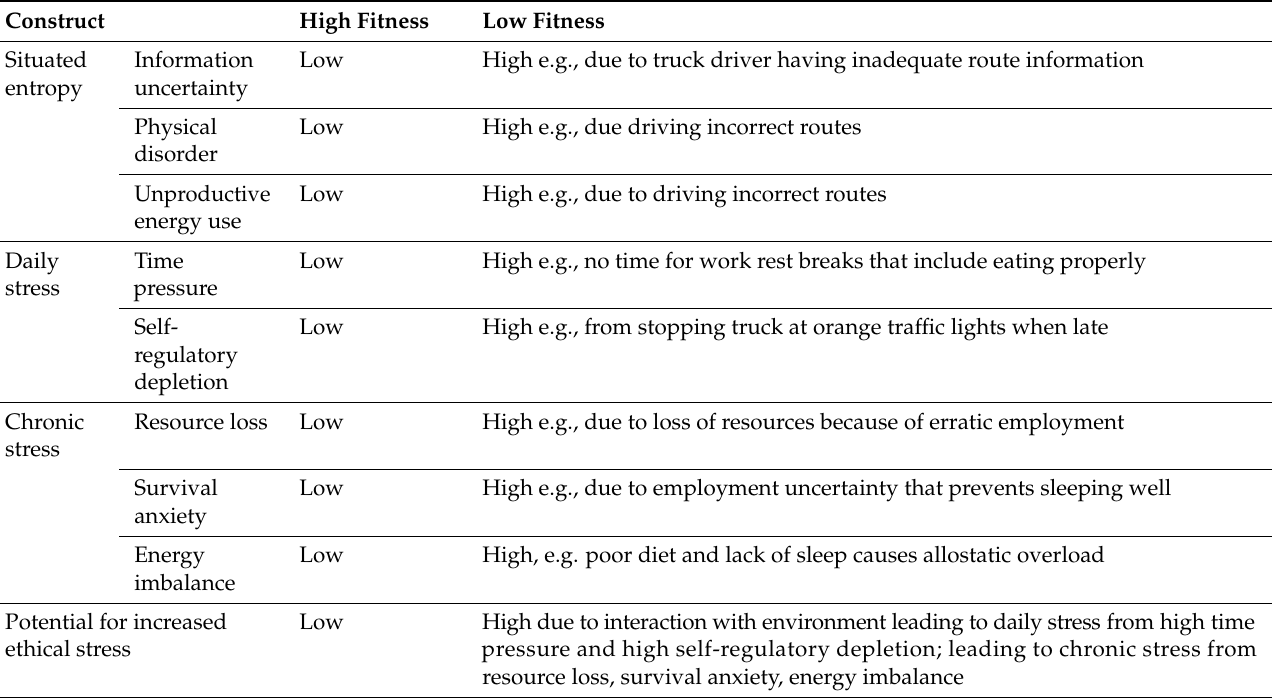
Table 1. Function: Interrelationships between function fitness, situated entropy, and ethical